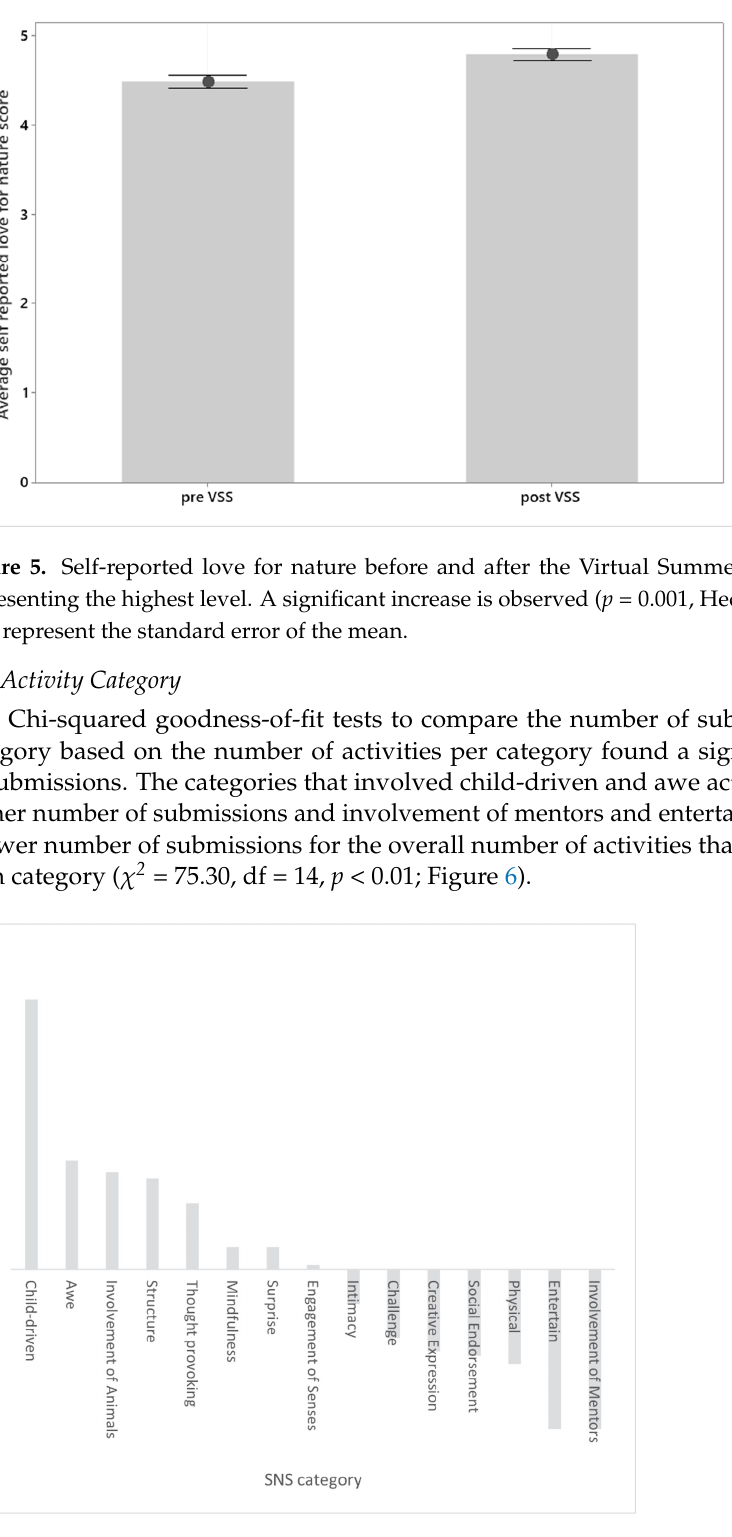
Figure 4. Violin plot of time spent together as a family (in hours per day) before and during the virtual summer school.